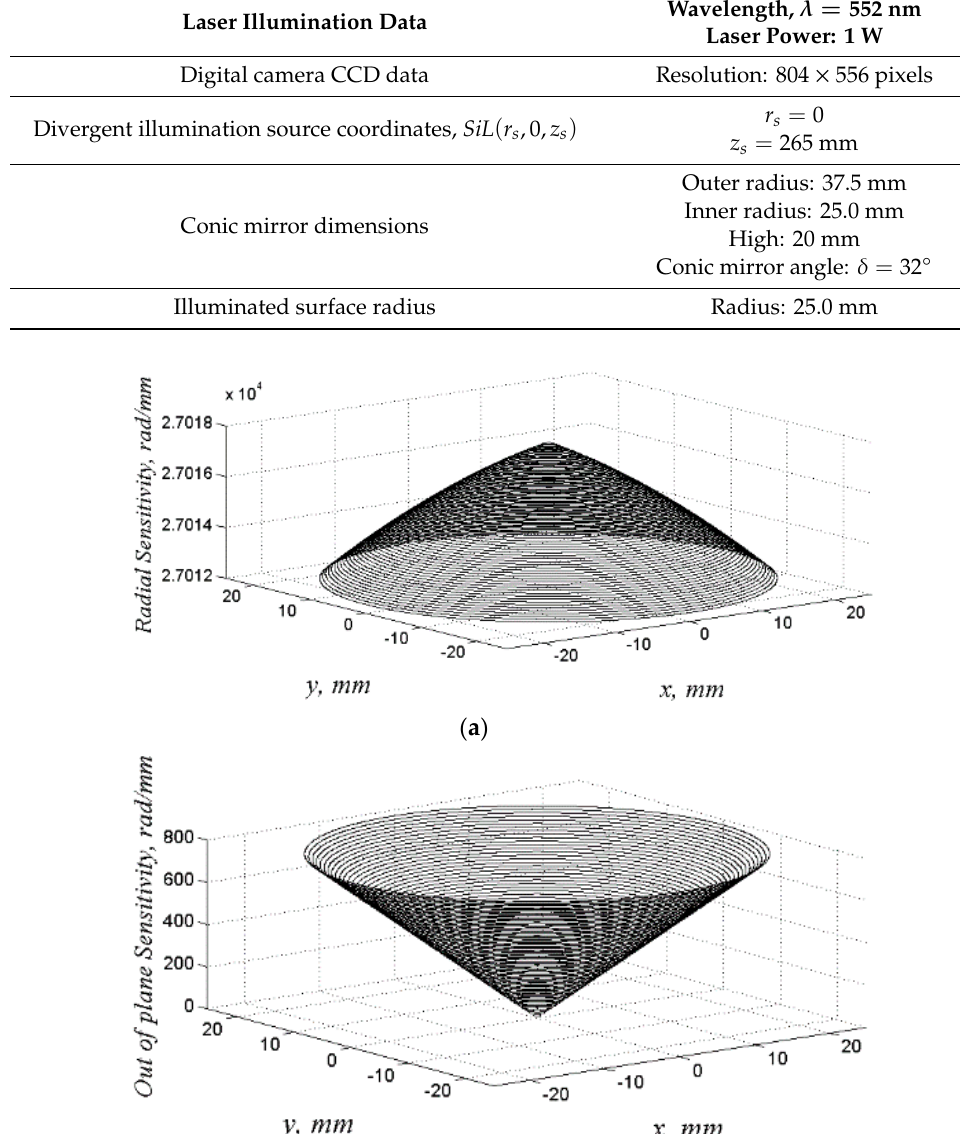
Table 1. Data for the numerical analysis.